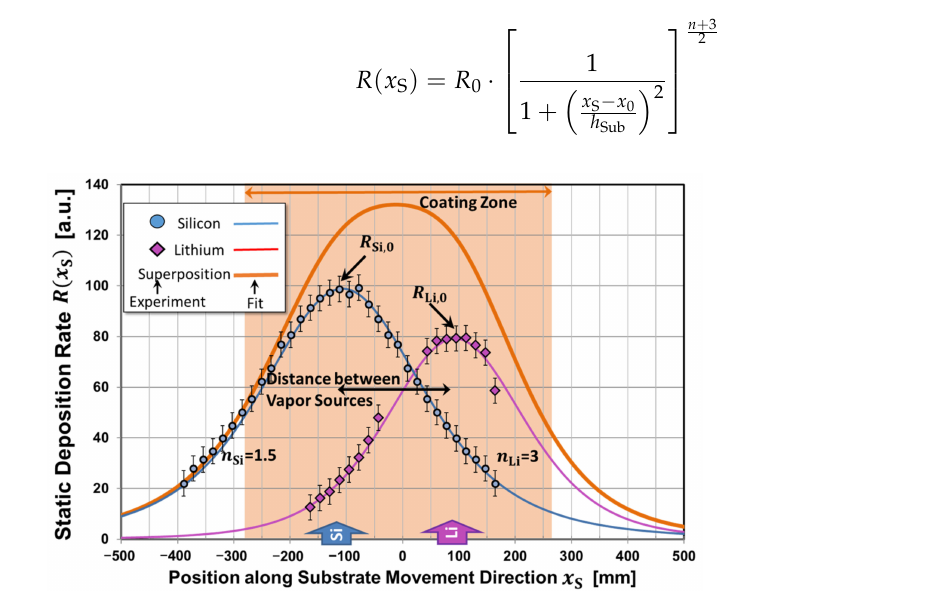
Figure 9. Measured lateral distribution of static deposition rate for silicon and lithium together with fits and their